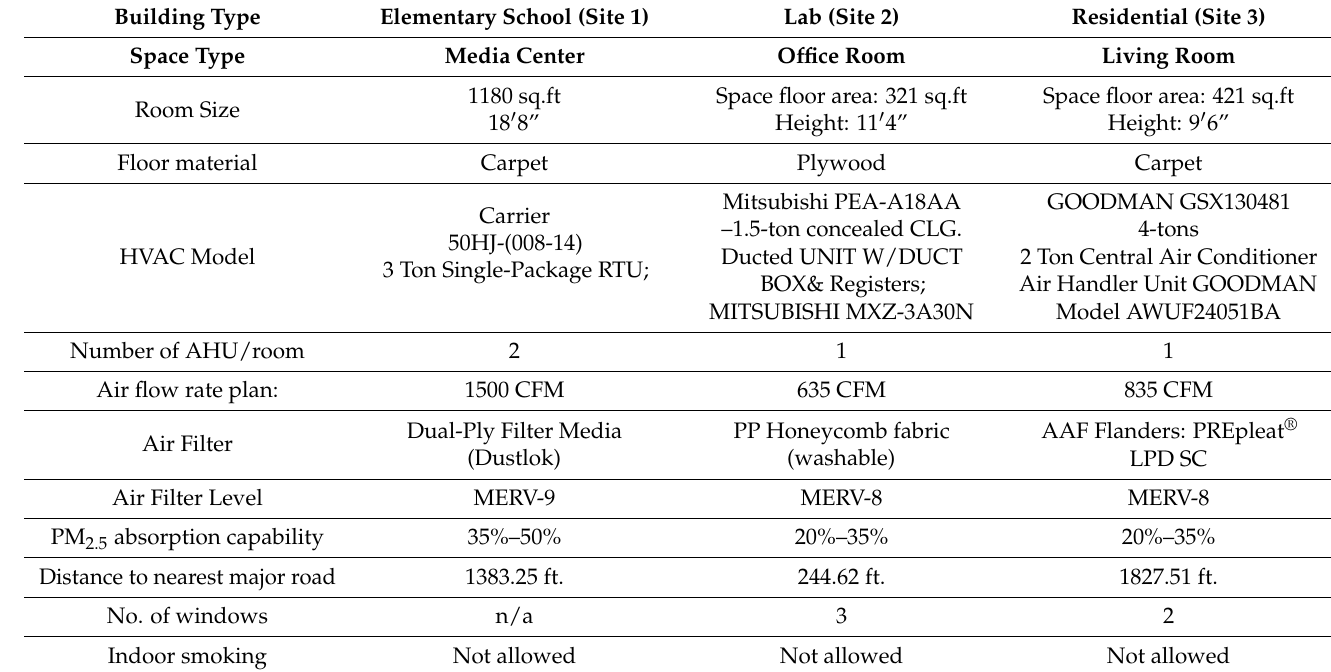
Table 1. Building-related specifications at each site.